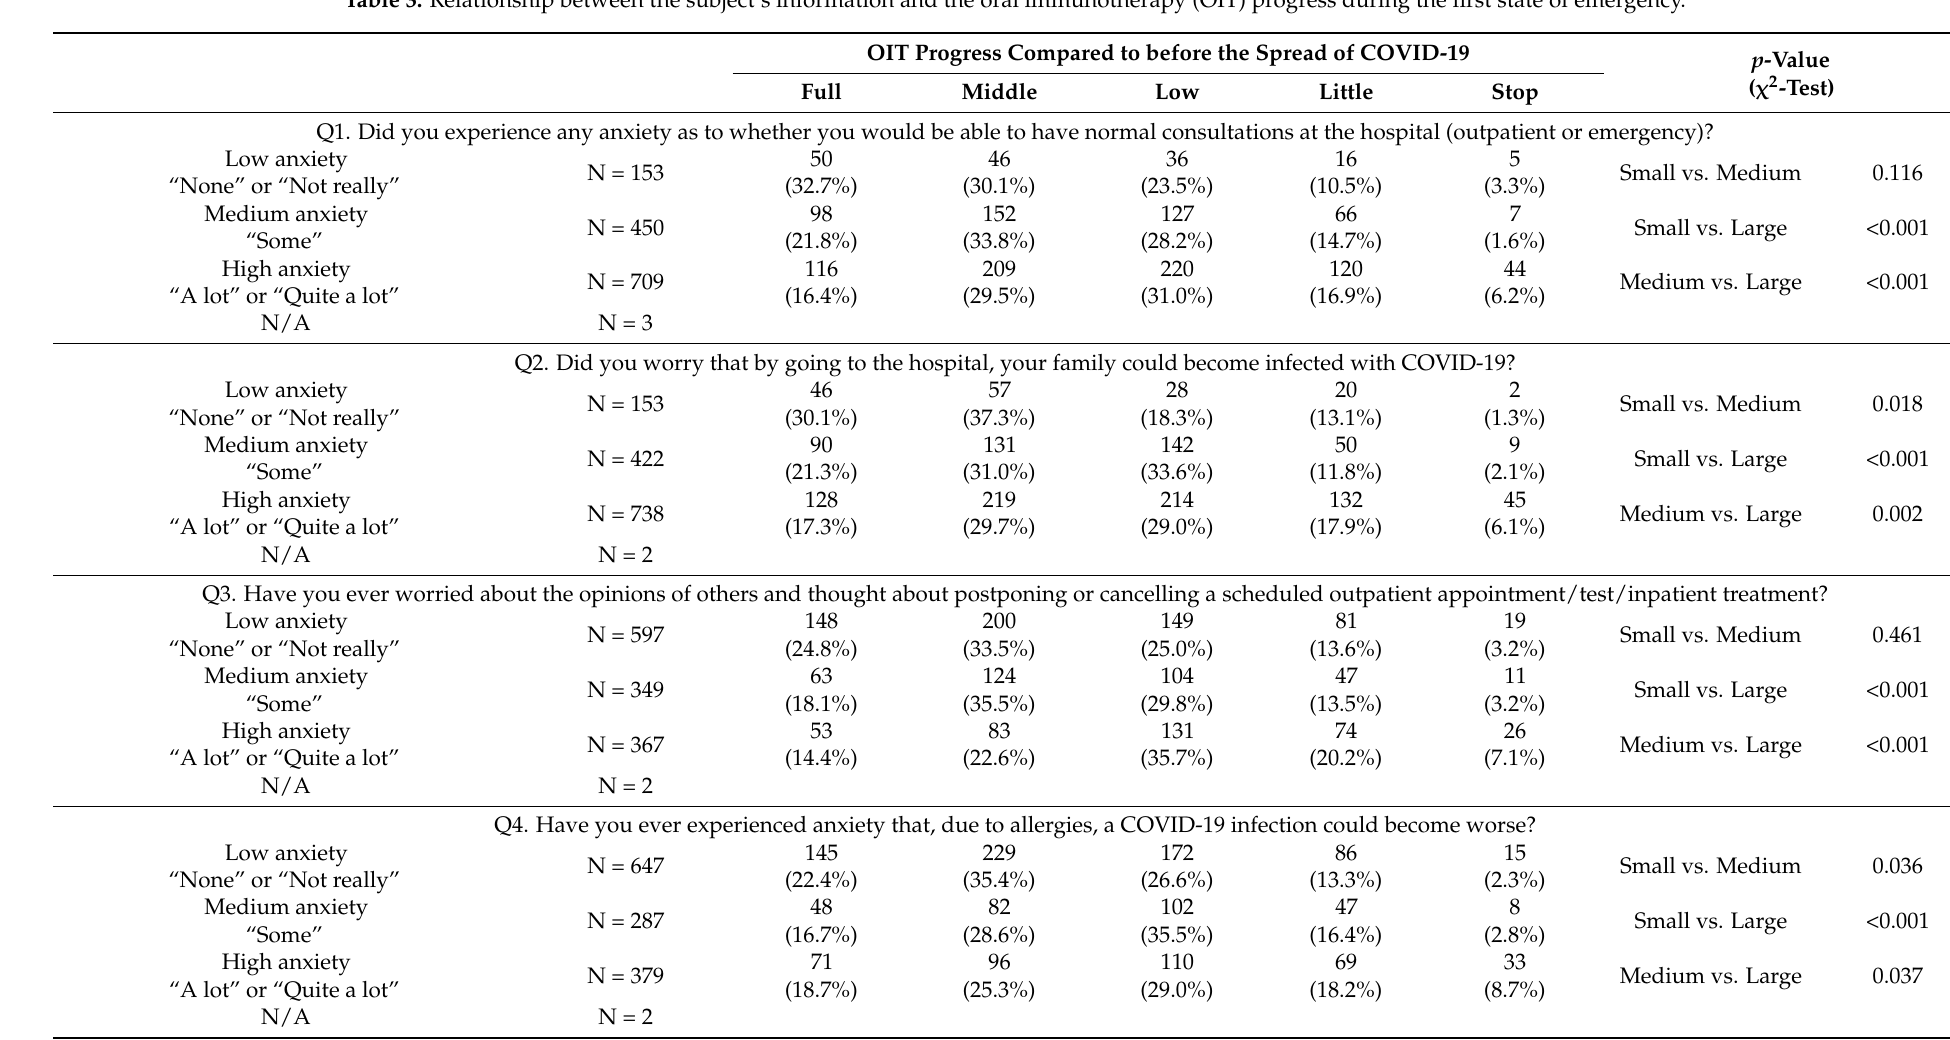
Table 3. Relationship between the subject’s information and the oral immunotherapy (OIT) progress during the first state of emergency. OIT Progress Compared to before the Spread of COVID-19 p -Value